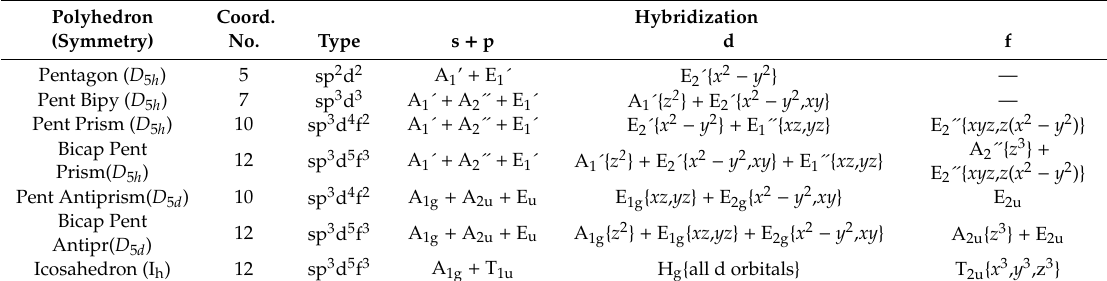
Table 4. Hybridization schemes for the pentagonal